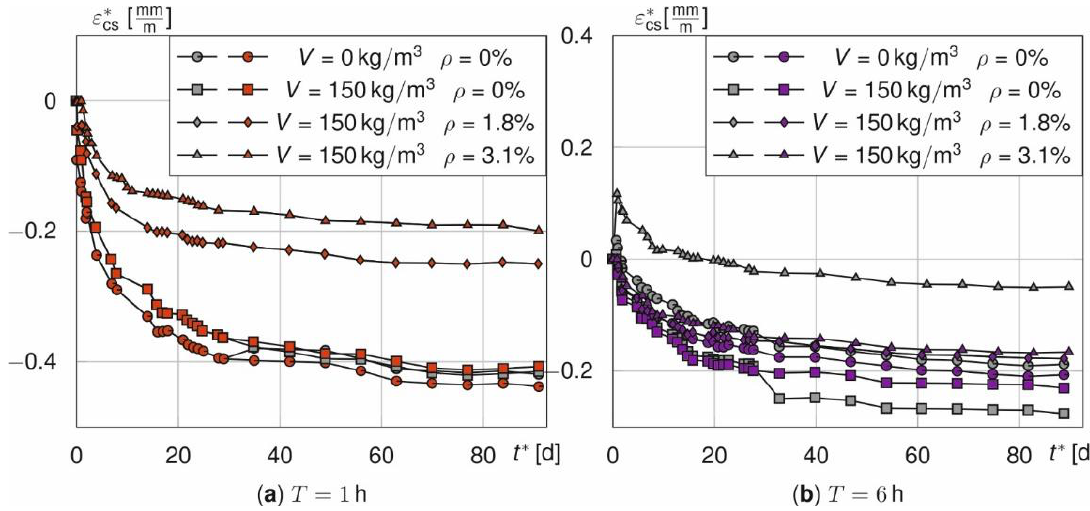
Figure 12. Comparison of the adjusted and shifted (red, purple) as well as the measured shrinkage curves (grey) of prisms and beams for T = 1 h ( a ) and T = 6 h ( b ).